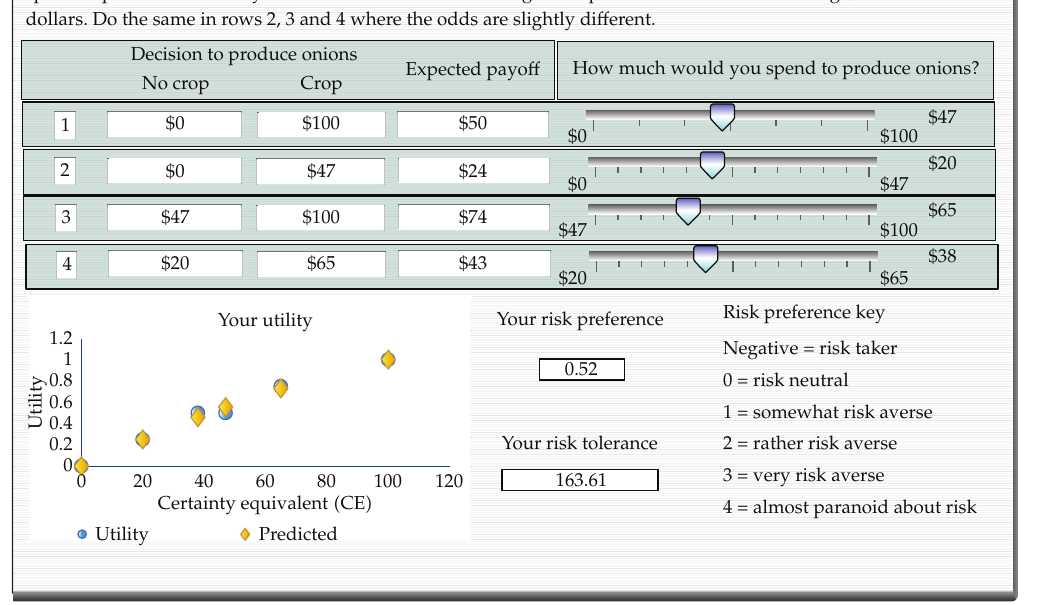
derivative of utility for